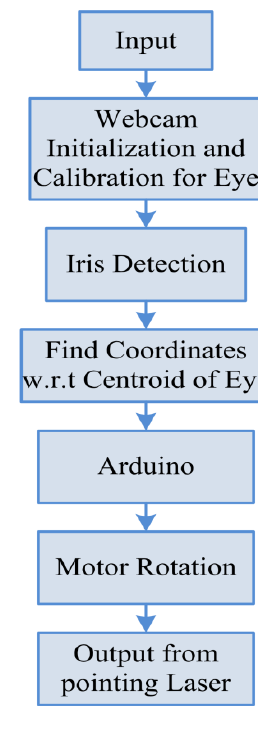
Figure 5. Flow chart of the eye ball tracking system